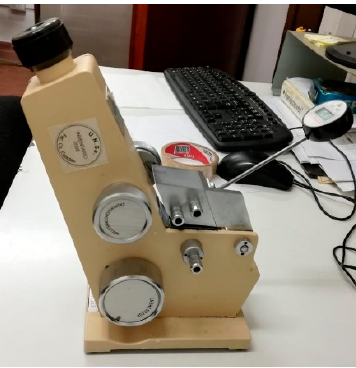
Figure 5. Krüss AR4 refractometer used in the experiments.